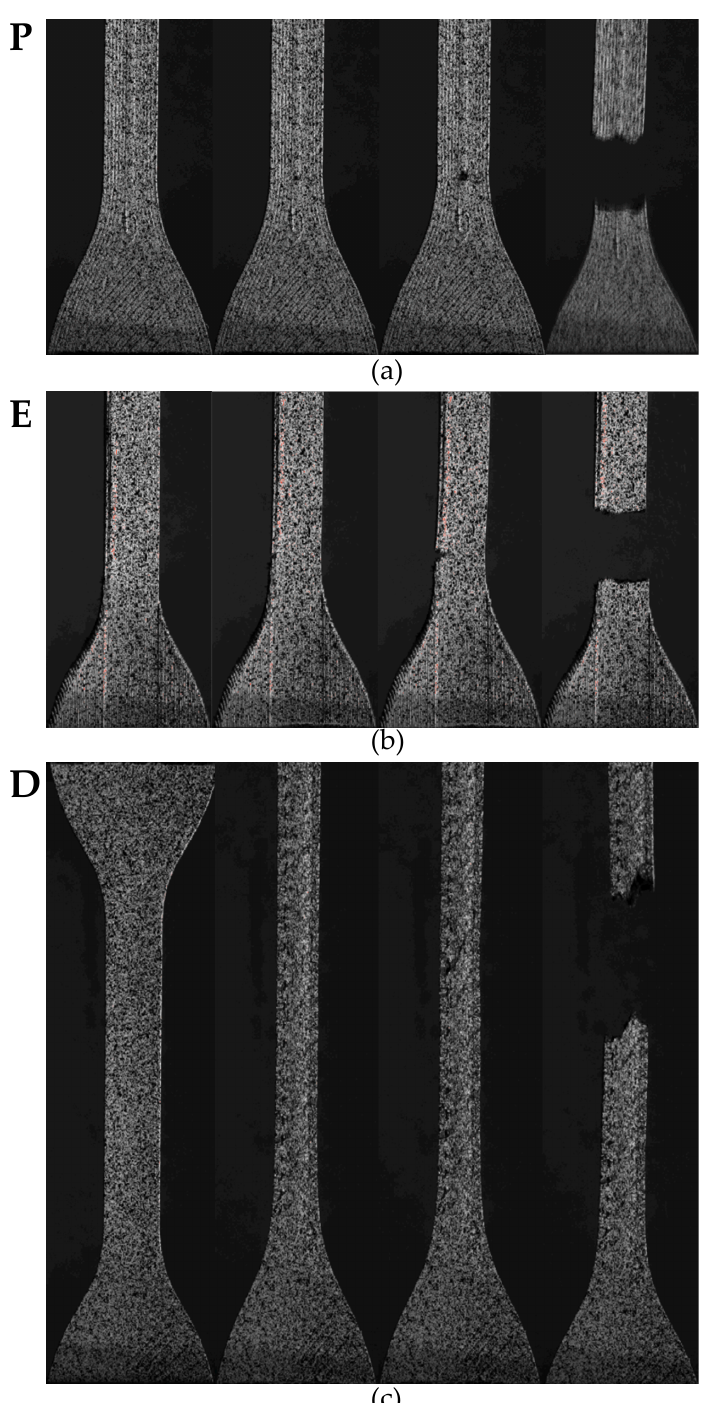
Figure 4. Failure mechanisms of tensile specimens showing ( a ) initiation and development of a void caused by a print defect in the parallel specimens; ( b ) initiation and development of a crack caused by a print defect in the on-edge specimens; and ( c ) failure in the gauge section of a standard